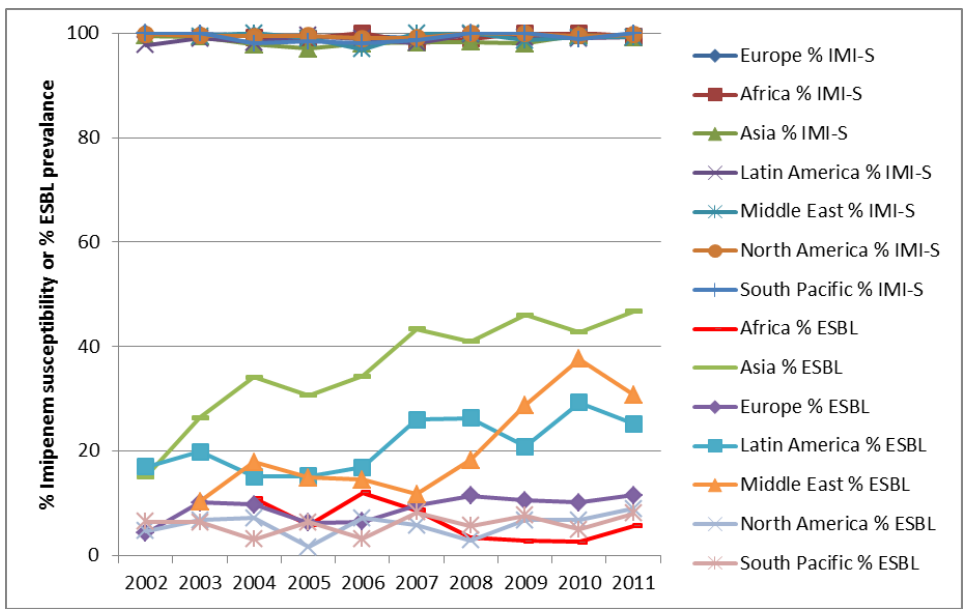
Figure 4. Susceptibility of E. coli from intra-abdominal infections to imipenem (IMI-S) and prevalence of ESBLs by region from SMART 2002 to